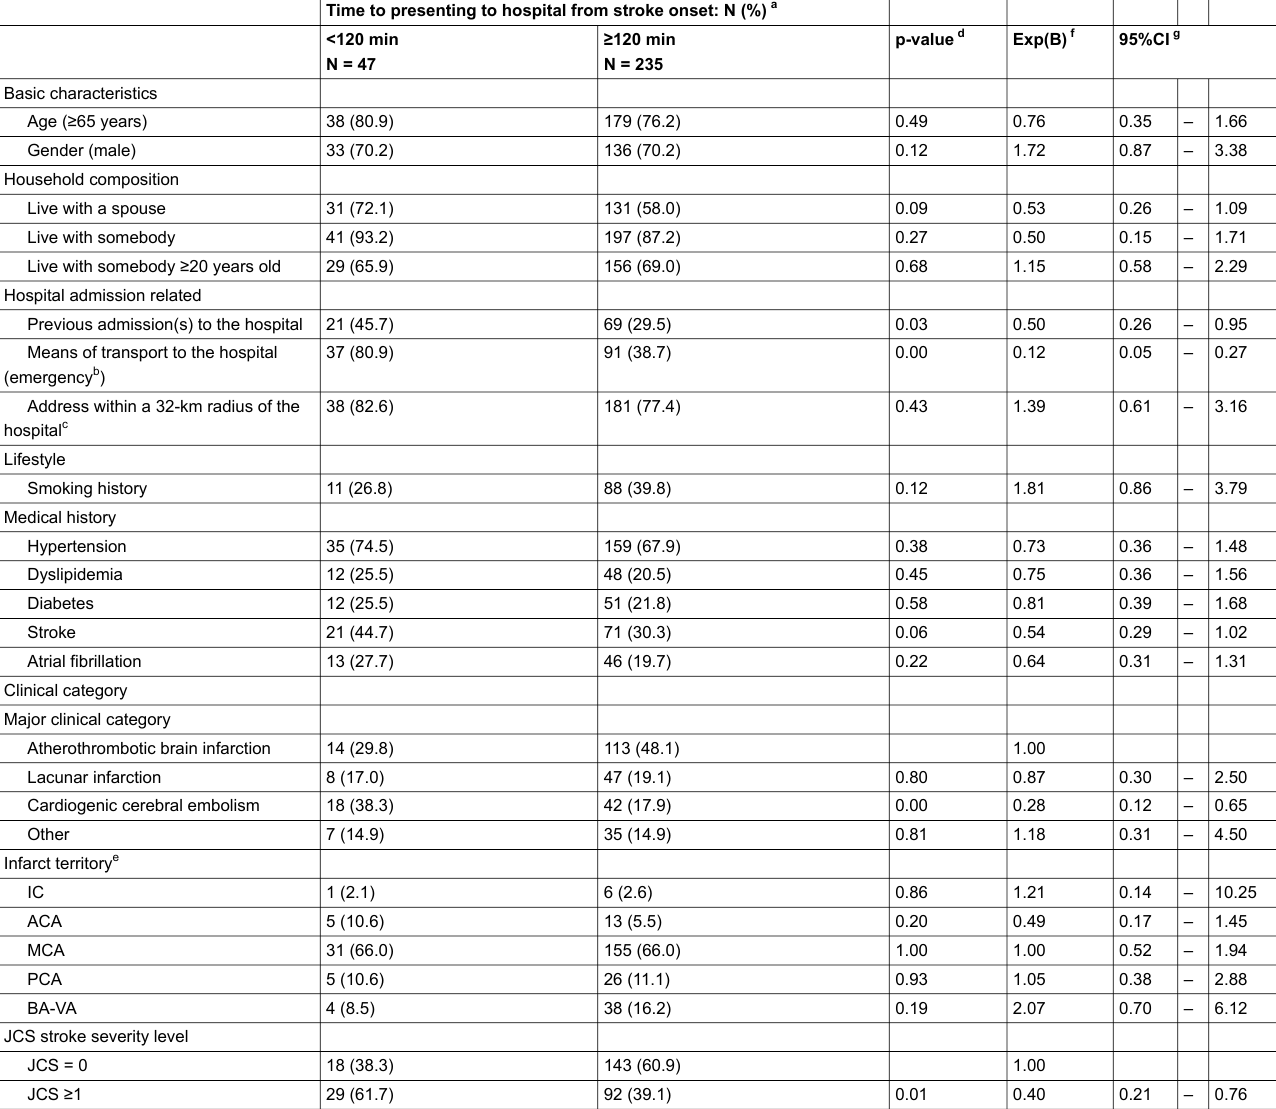
Table 1: Association between time to presenting to hospital and patient characteristics: Univariate analysis using data of all patients.